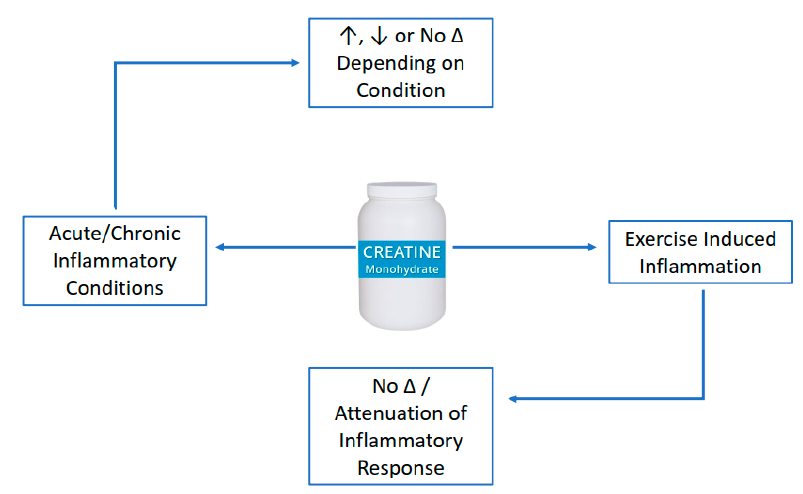
Figure 1. Anti-inflammatory of creatine supplementation.